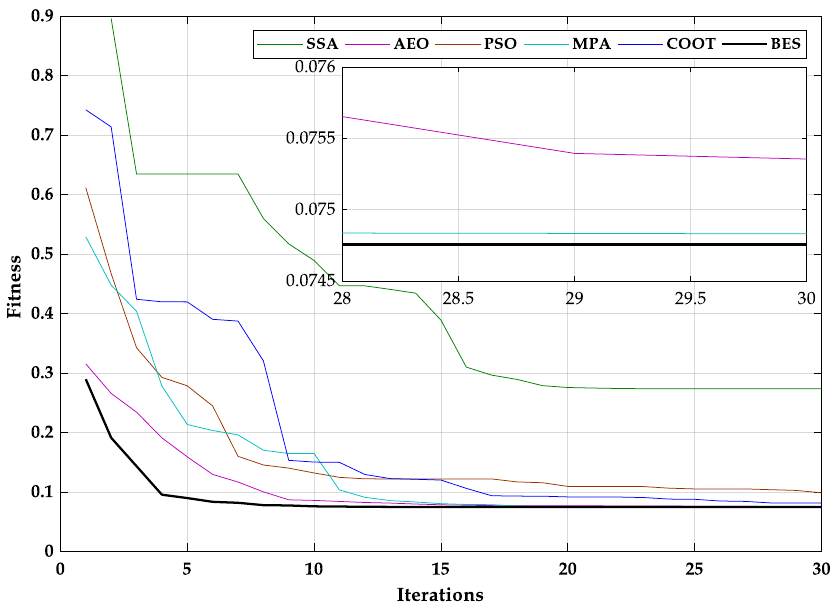
Figure 10. Mean fitness evolution as a function of the iterations.